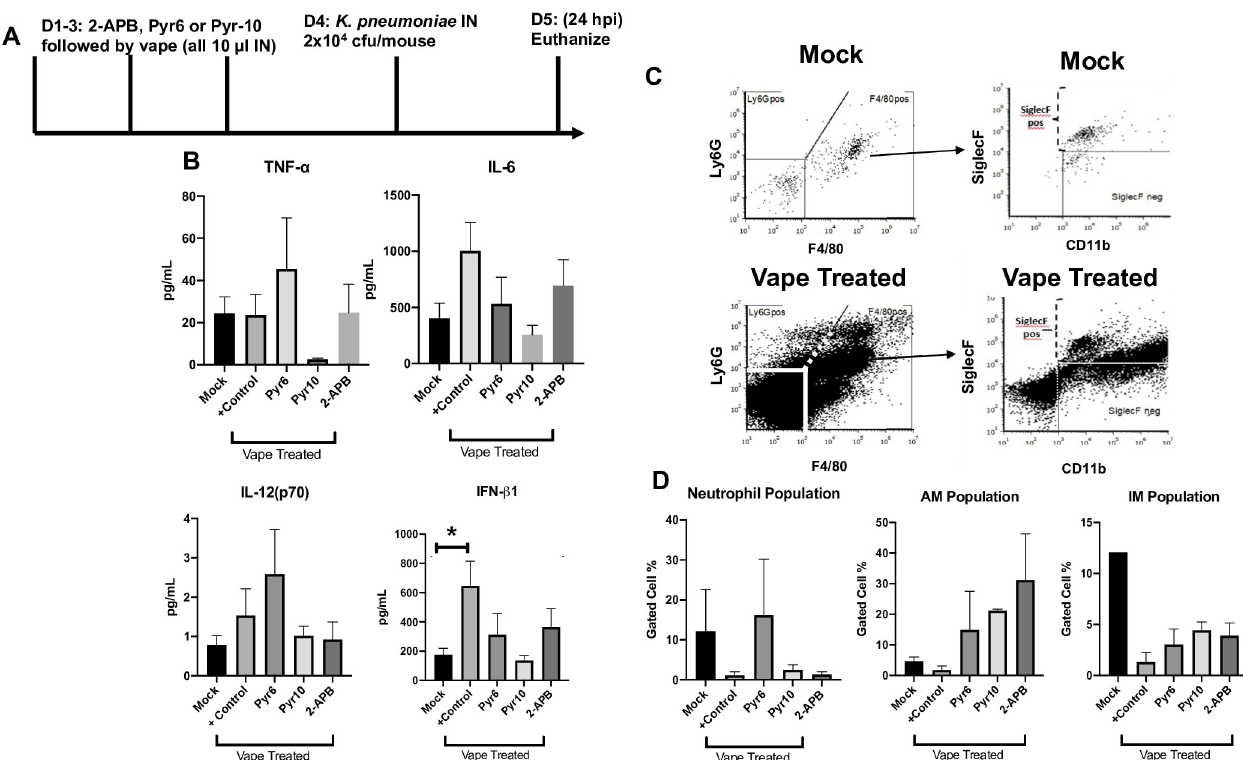
Fig 3. Ca 2+ channel antagonists differentially regulate vape-induced inflammation when the treatments are supplemented with a subsequent 24-h pathogen challenge. (A) Study design. Mice were simultaneously vaped and treated with the Ca 2+ channel antagonists Pyr6, Pyr10 or 2-APB, then challenged with a sub-lethal dose of K . pneumoniae and euthanized for BAL fluid and lung tissue collection. n = 6 mice per treatment group. (B) Clarified BAL was run using the Luminex cytokine panel. (C) Collected BAL fluid cells were then analyzed via flow and (D) tabulated. IM = SiglecF-/CD11b+ and AM = SiglecF +/CD11b+. AM = alveolar macrophage, IM = interstitial macrophage, neutrophils = F4/80-/Lys6G+. Symbols and bars represent the mean ± SEM compared to the mock control ( � P < 0.05).